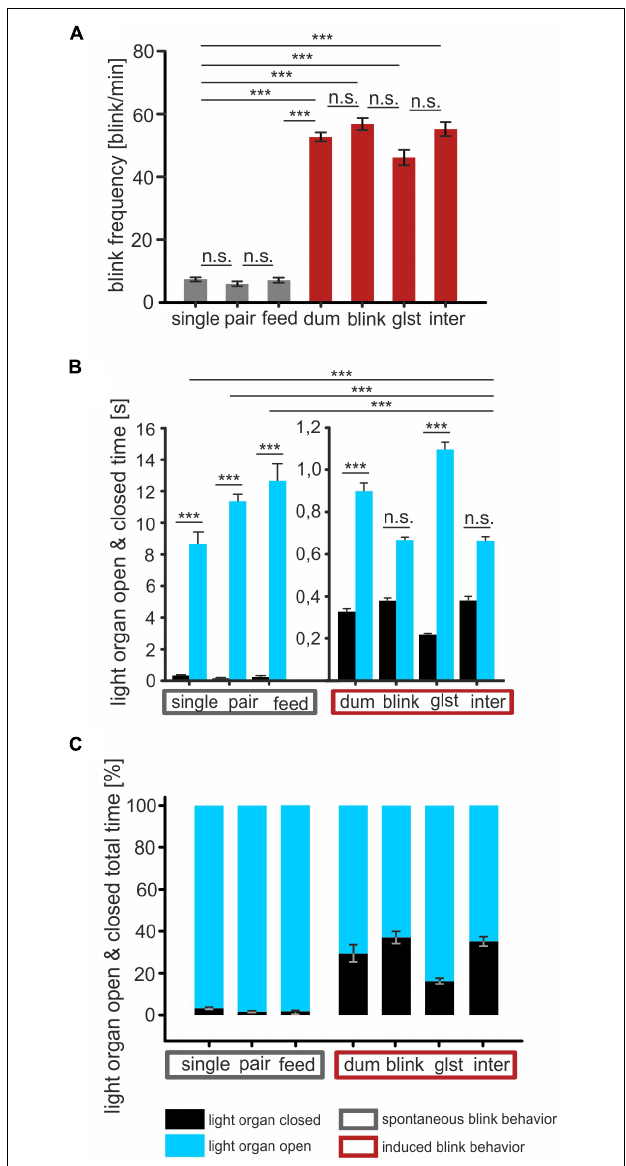
FIGURE 3 | Blink behavior and light organ open and closed times of P. steinitzi during feeding and exposure to artificial and intraspecific intruders. (A) Blink frequency (blinks/min) in P. steinitzi in undisturbed specimens (single) or pairs (pair) and during feeding zooplankton organisms (feed). Photoblepharon steinitzi show increased blink frequencies during confrontation with: a constant glowing fish dummy (dum), a blinking (1 Hz) LED/light organ dummy (blink), a constant glowing glow stick/light organ dummy (glst) and during intraspecific interactions triggered by a conspecific intruder (inter). Gray bars indicate blinking behavior in undisturbed specimens. Red bars indicate blinking behavior during exposure to artificial and intraspecific intruders. (B) Mean time intervals of single open and closed times of light organs. Black bars indicate closed light organs. Blue bars indicate open light organs. Rectangle with gray frame indicate conditions in undisturbed fish. Rectangle with red frame indicate conditions during exposure to artificial and intraspecific intruders as described in above. (C) Total relative distribution of open and closed light organs in percent of 5 min recording intervals. Color coding of bars and rectangles as described in (A,B) . Error bars indicate mean ± SEM. Significance values are reported as: * p ≤ 0.05; ** p ≤ 0.01; *** p ≤